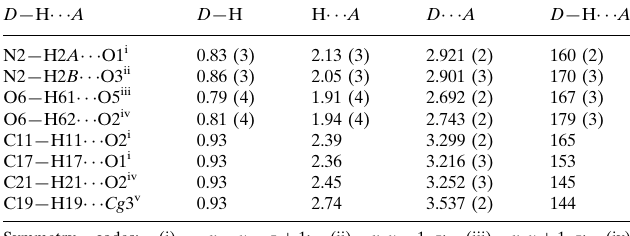
Hydrogen-bond geometry (A˚ , (cid:3)